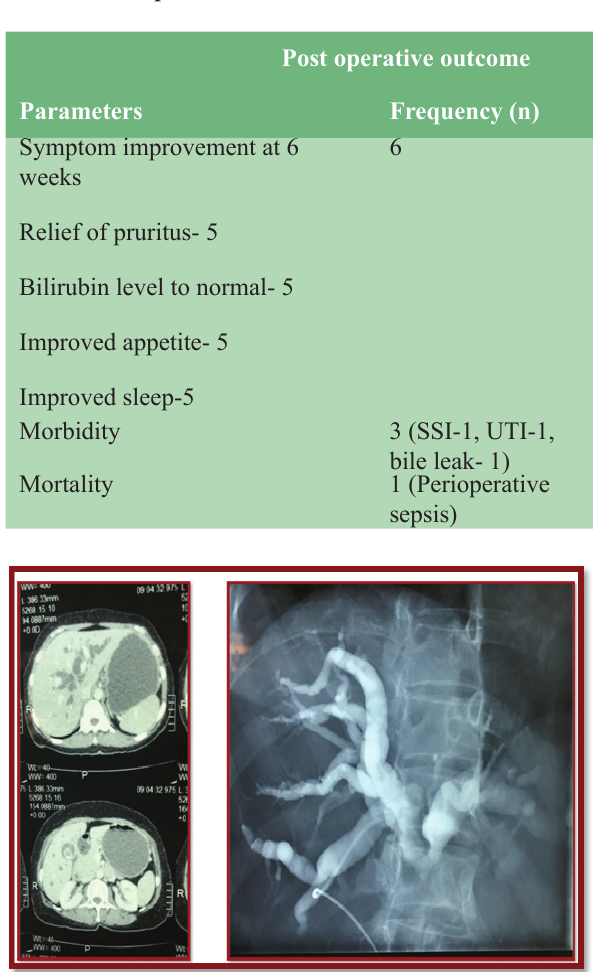
Table 2. Postoperative outcome